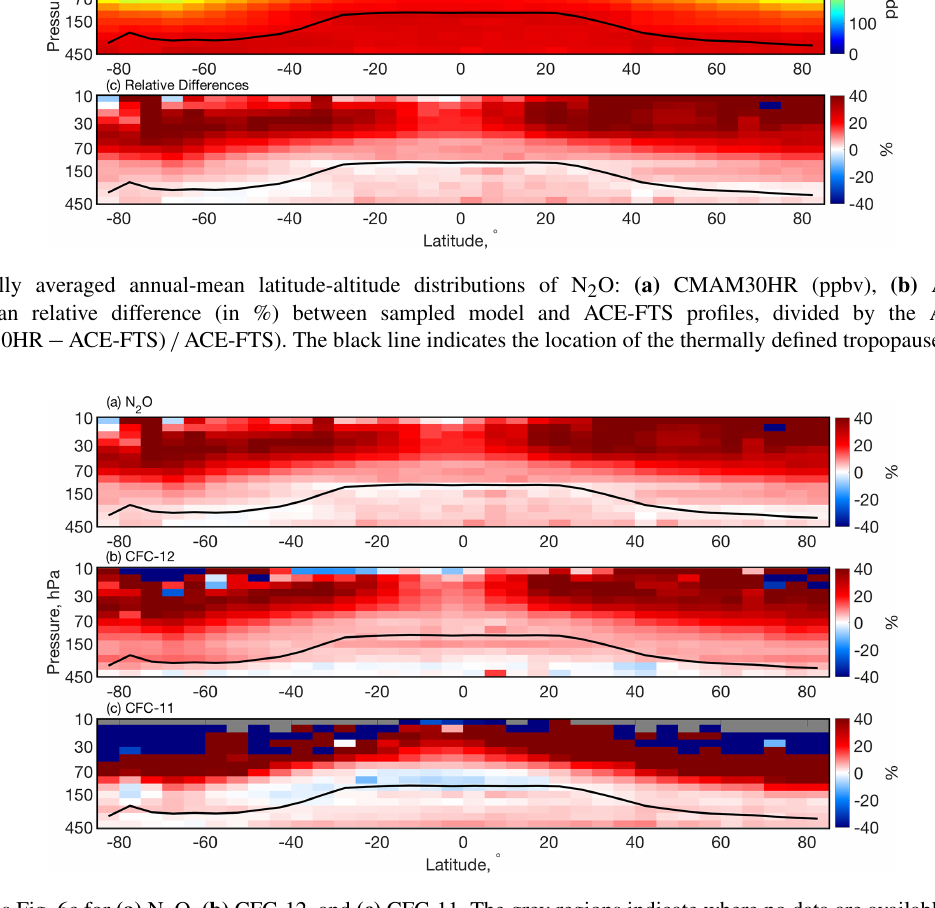
Figure 7. Same as Fig. 6c for (a) N 2 O, (b) CFC-12, and (c) CFC-11. The grey regions indicate where no data are